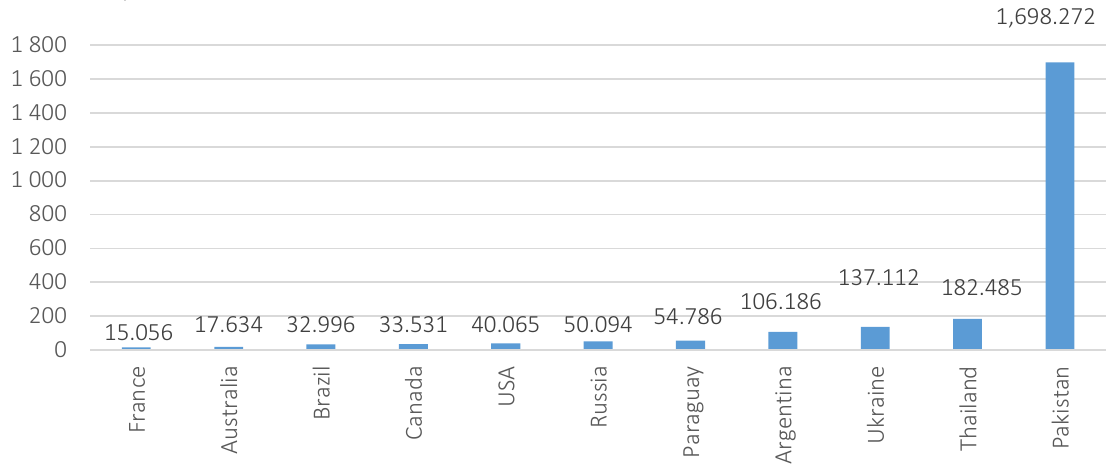
Figure 5. Average calculated water capacity of GDP of influential countries, which are the main world exporters of grain for the period 1975–2015, ths m 3 per 1